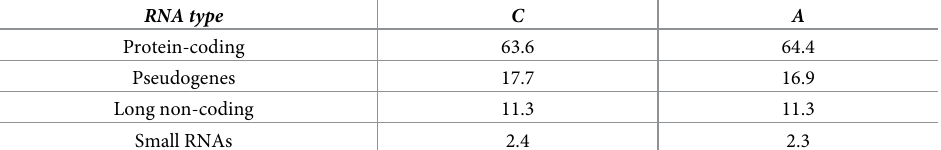
Table 2. Percentages of transcript types detected in tumour core resections (C) and cavitational ultrasonic surgi- cal aspirates (A).